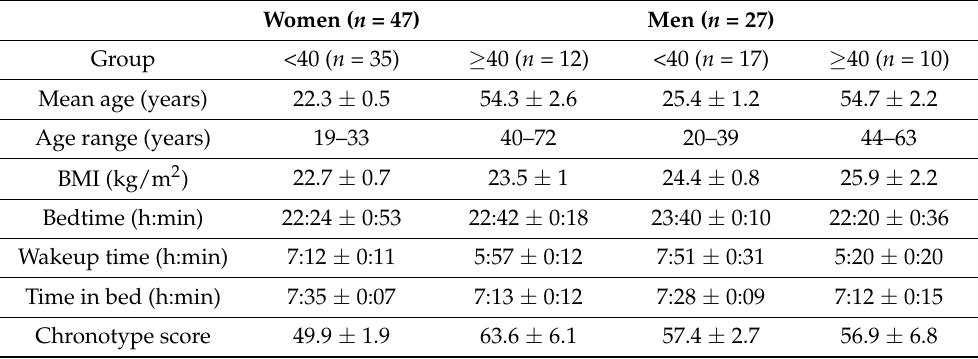
Table 1. Baseline characteristics of participants. Bedtime and Wakeup time—habitual sleep and wakeup times according to sleep diary; Time in bed—time between bedtime and getting up time according to actigraphy; Chronotype score according to CTQ. Data are presented as mean ± SEM for women and men participants divided by age (<40—women/men younger than 40 years; ≥ 40— women/men 40 years and